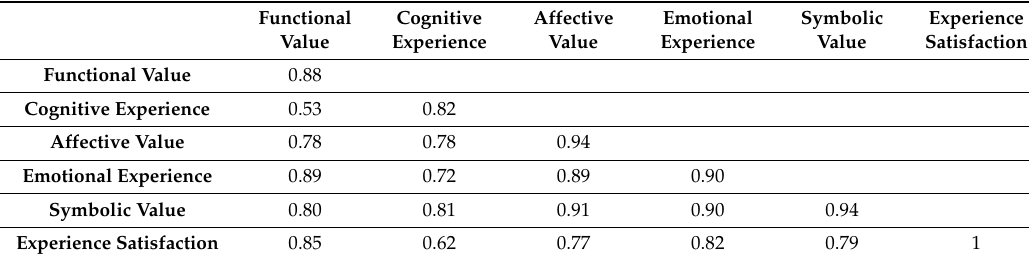
Table 3. Construct correlation coefficient